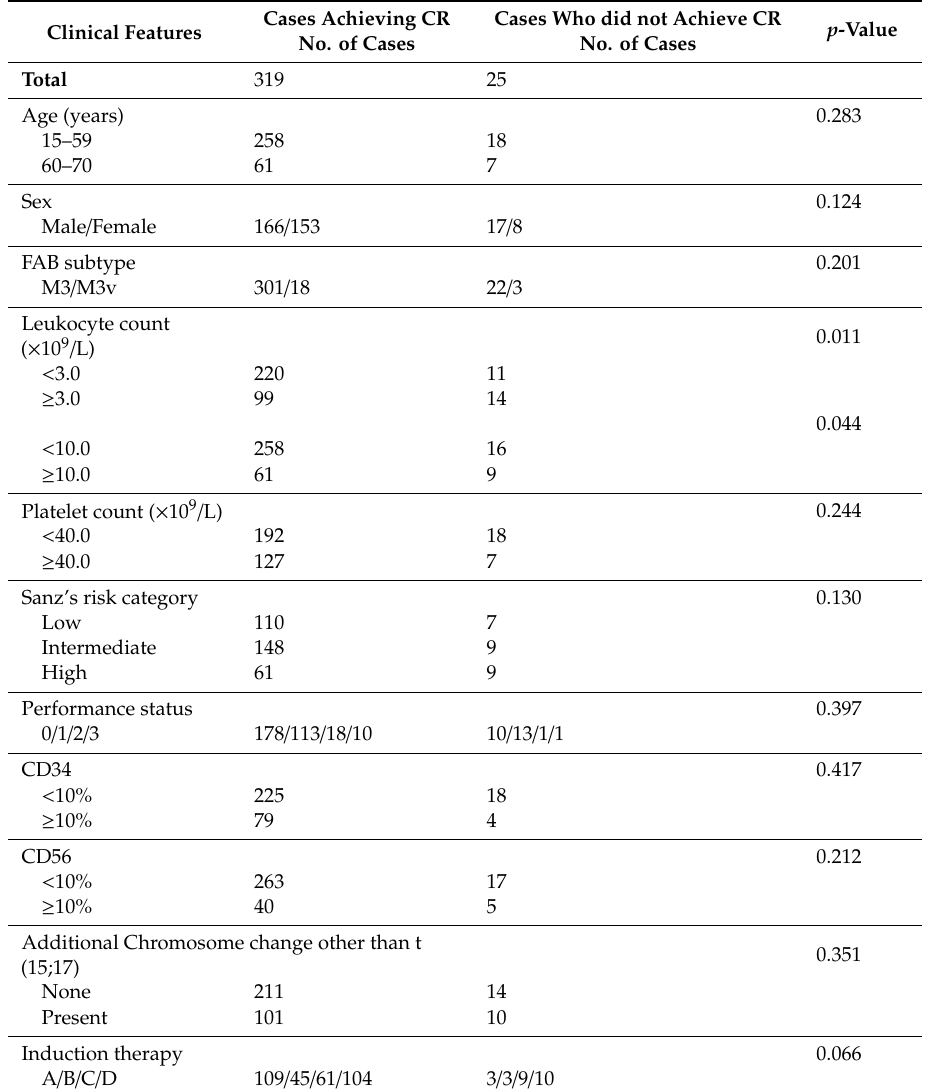
Table 2. Risk factors for